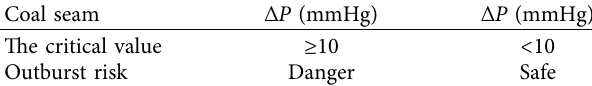
Table 3: Indicator thresholds. Coal